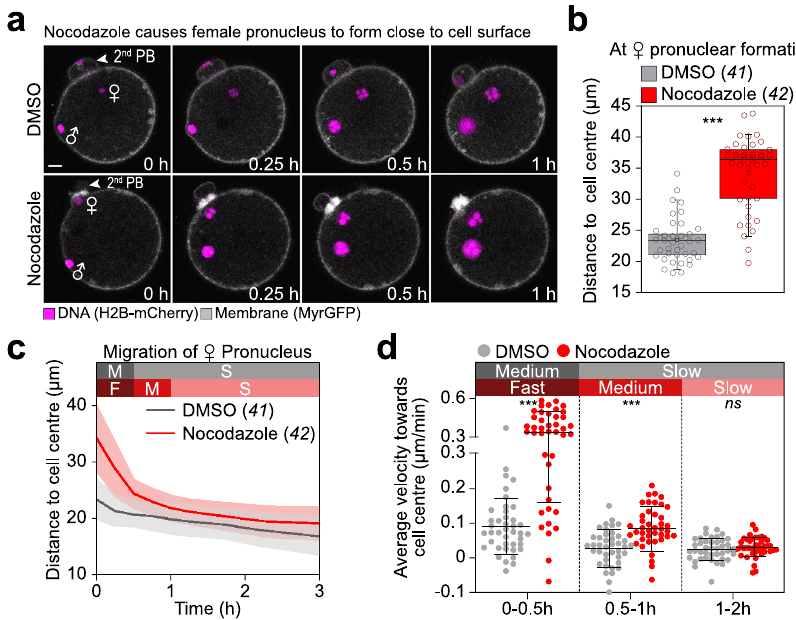
Fig. 2 Female pronuclei have a pronounced fast migration phase when forced to form close to the cell surface. a Three-dimensional time-lapse images of pronuclei (H2B-mCherry) and the cell surface (MyrGFP) relative to pronuclear formation (0 h) in zygotes treated with DMSO or 1 µ M nocodazole. Female ( ♀ ) and male ( ♂ ) genomes are labelled; as well as the second polar body (PB). Scale bar, 10 μ m. b Distance of female pronuclei formation site from the cell centre relative to pronuclear formation (0 h) in DMSO- and nocodazole-treated zygotes calculated from data sets as shown in ( a ). All individual values (circles) are overlaid with a box plot showing median (line), mean (small square), 5th, 95th (whiskers) and 25th and 75th percentile (boxes enclosing 50% of the data) calculated from the total number of zygotes (italics) and pooled from four independent experiments. Two-tailed Student ’ s t test was used to test for signi fi cance ( p < 0.0001). c The mean distance (thick line) of female ( ♀ ) pronuclei centroids to zygote centre relative to pronuclear formation (0 h) in DMSO- and nocodazole-treated zygotes was calculated from ( a ). Phases of respective movement speeds are classi fi ed as in Fig. 1a. Total number of analyzed zygotes (italics) was pooled from four independent experiments. S.d. shown as shaded areas. d Statistical plots of average velocities of female ( ♀ ) pronuclei during pronuclear migration in DMSO- or nocodazole-treated zygotes calculated from ( c ) with the same sample size as in ( c ). Statistical plots as in Fig. 1c. Two-tailed Student ’ s t test was used to test for signi fi cance (from left to right: p < 0.0001, p < 0.0001 and p =